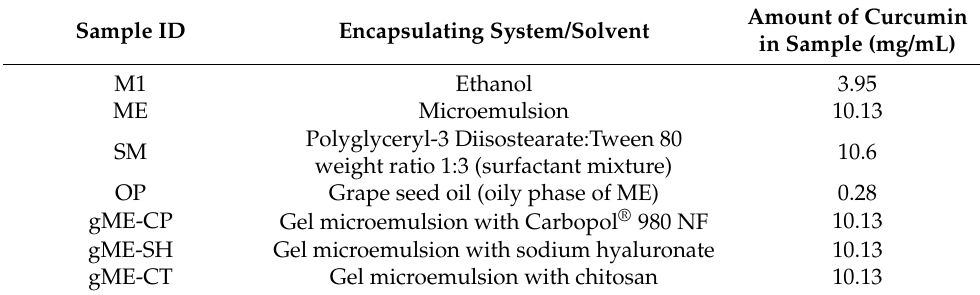
Table 1. Sample ID and amount of curcumin encapsulated in each of the